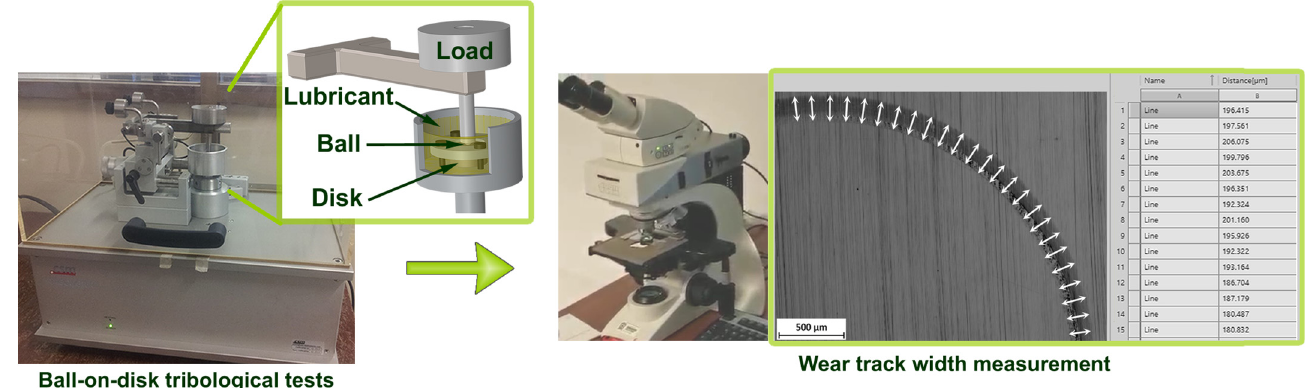
Figure 2. Configuration for friction studies and wear measurements.